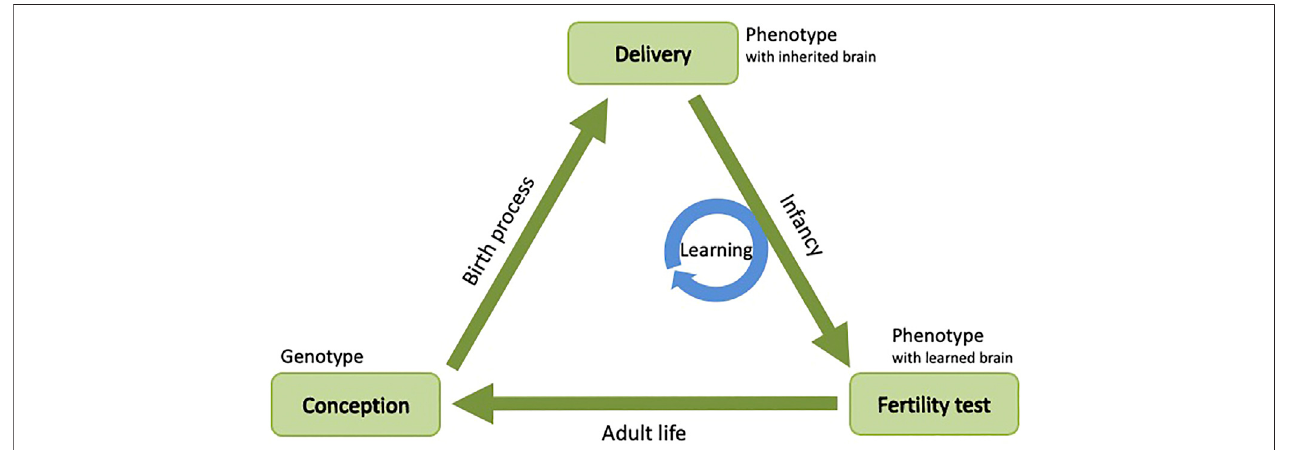
FIGURE 1 | Generic system architecture for robot evolution conceptualized by the Triangle of Life, after Eiben et al. (2013).